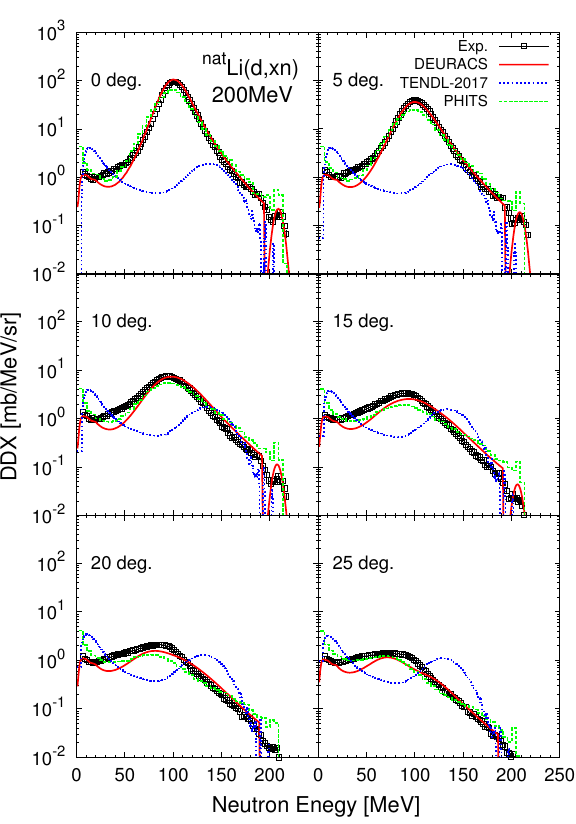
Figure 5. Comparison of measured DDXs for Li at emission angles from 0 ◦ to 25 ◦ with DEURACS and PHITS calculations, and TENDL-2017 nuclear